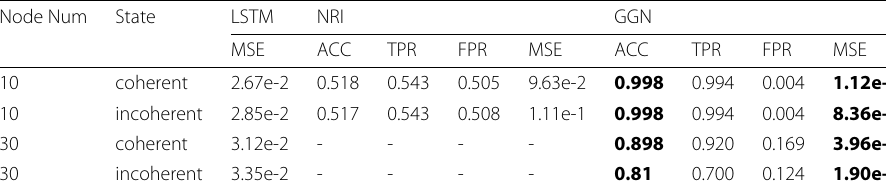
Table 3 Results with Kuramoto model